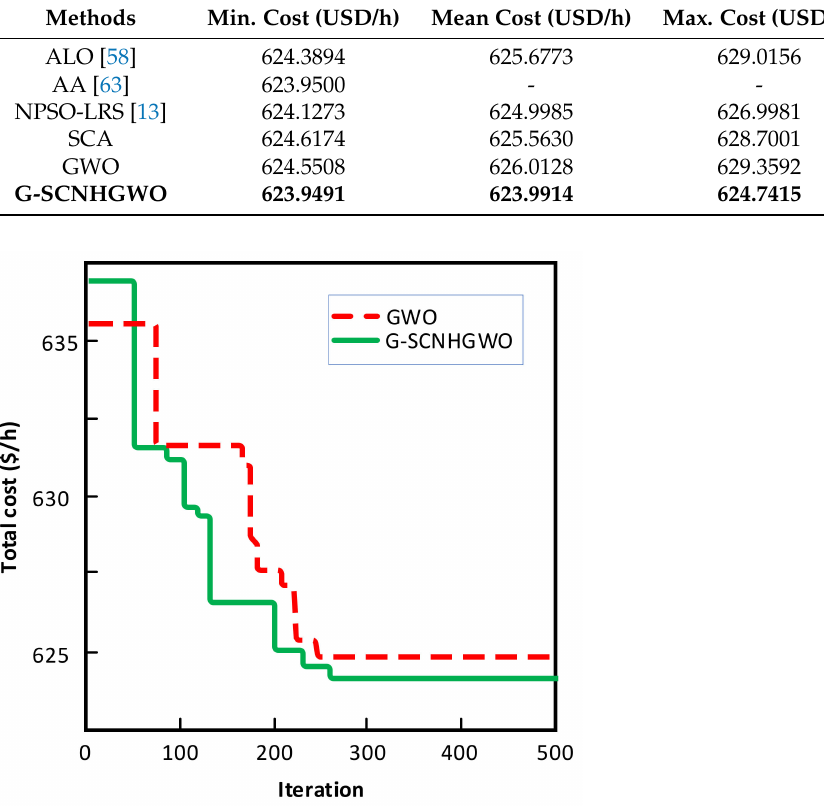
Figure 1. Convergence behavior obtained by GWO and G-SCNHGWO algorithms for Case A-type 2. Table 3. The best decision variables for Case A-type 1 obtained by G-SCNHGWO algorithm.